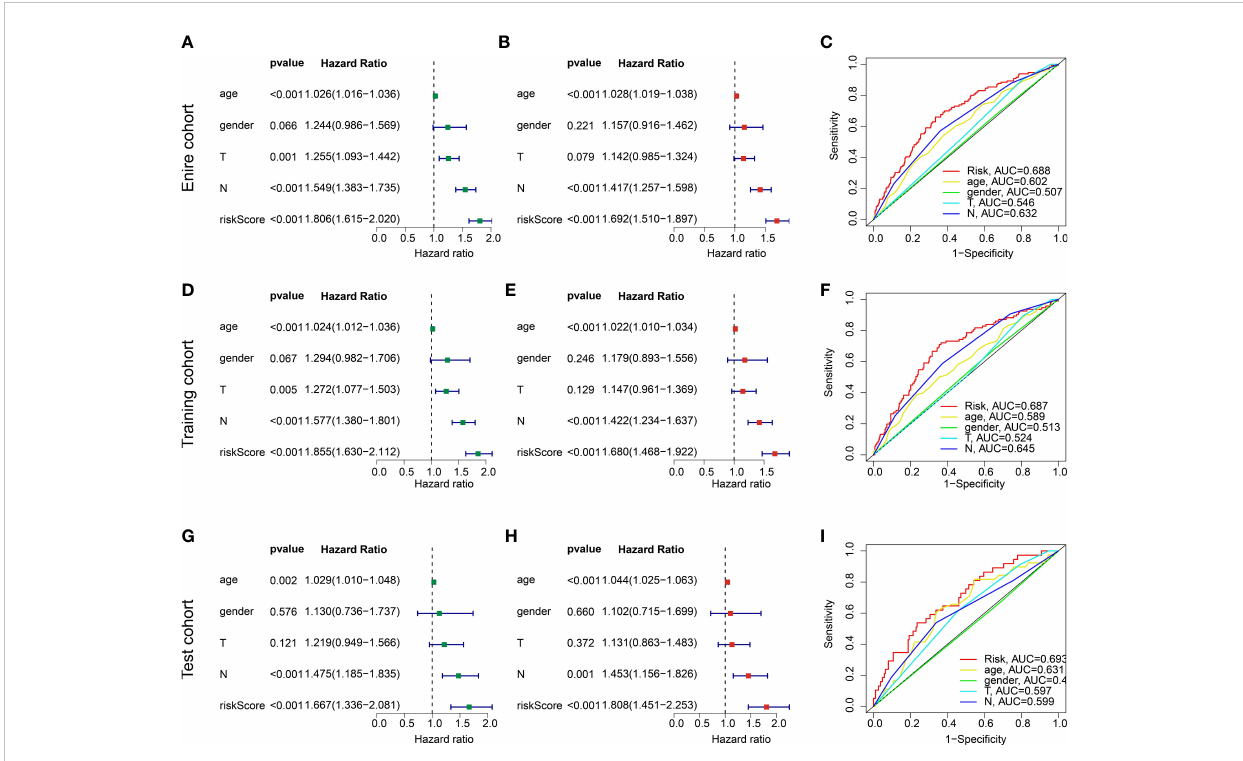
FIGURE 7 independent prognosis analysis of risk score and predictive ability evaluation. (A, B) Univariate and multivariate Cox analysis in entire cohort. (C) ROC curve. (D – F) Independence analysis and ROC curve in the training cohort. (G – I) Independence analysis and ROC curve in the test